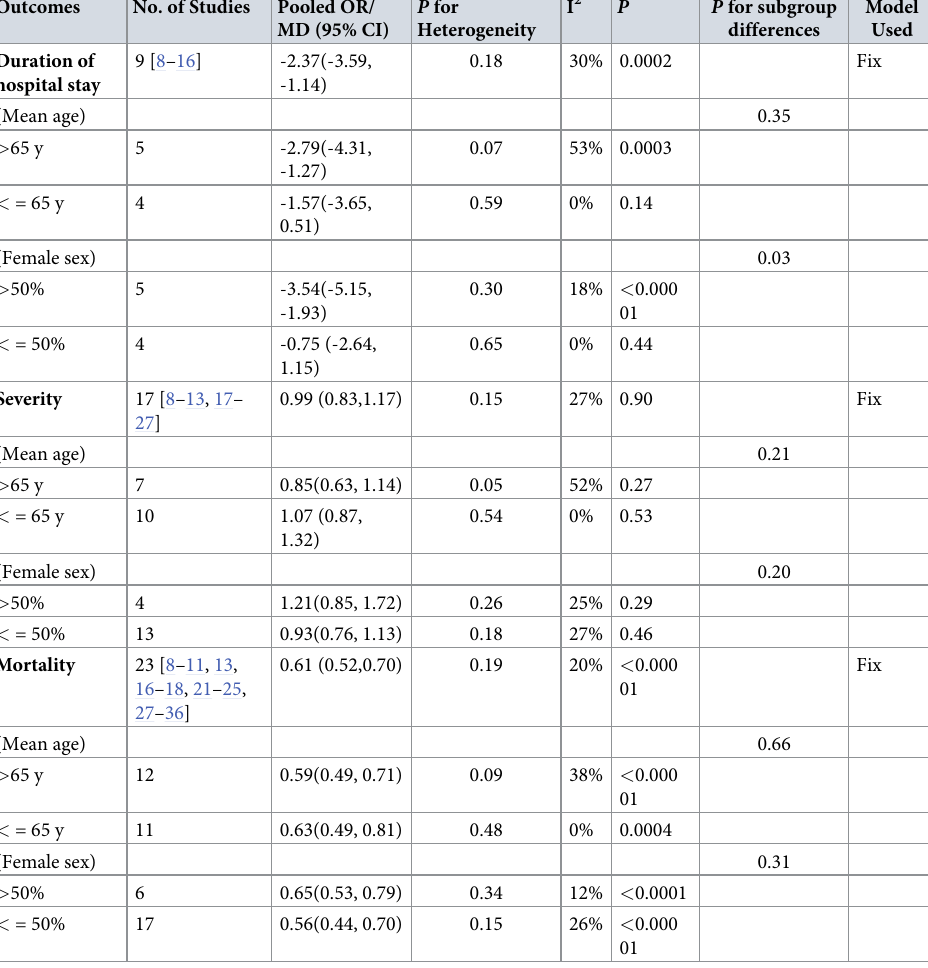
Table 2. Clinical outcomes of East-Asian Covid-19 patients treated with ACEI/ARB vs. untreated subjects (all studies).